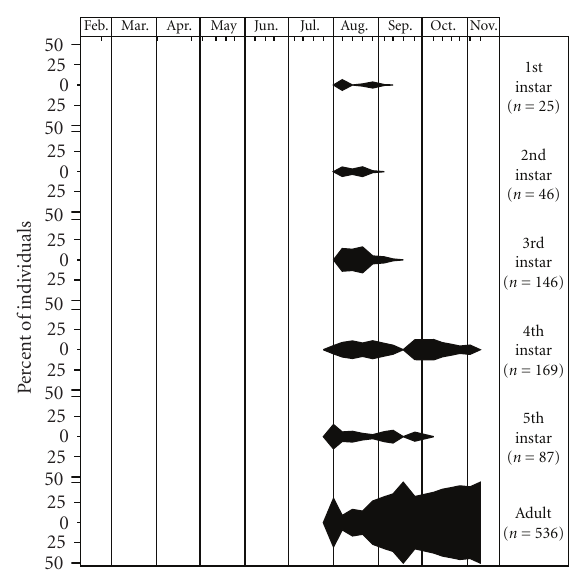
Figure 5: Percent of individuals of Rheumatobates tenuipes in each stage on each sample date.